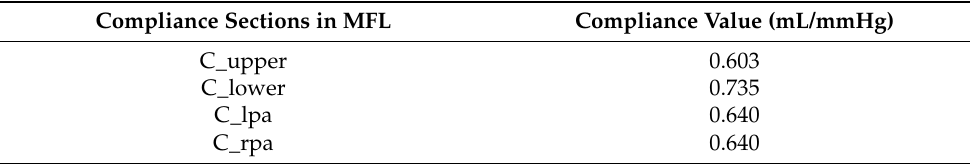
Figure 9. Reduced LPM representation of HCSII MFL setup. Table 3. Compliance values for MFL.